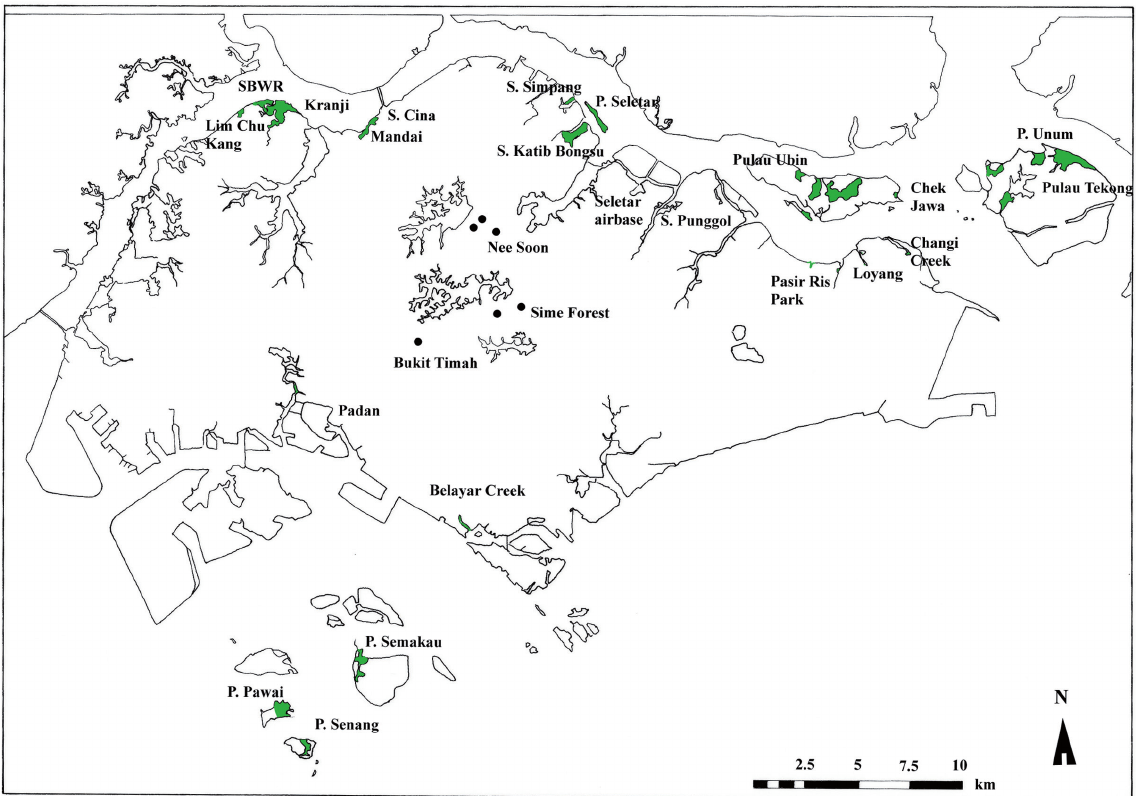
Fig. 2. Extent of the mangroves in Singapore (in green). During the SMIP project in 2009 Malaise traps sampled at Lim Chu Kang, Sungei Buloh Wetland Reserve, Kranji Nature Trail, Sungei Cina, Pulau Seletar, Pasir Ris, Changi Creek, Pulau Ubin (Chek Jawa), Belayar Creek and Pulau Semakau. Nee Soon, Sime forest and Bukit Timah are terrestrial reference sites (map made with help of NParks